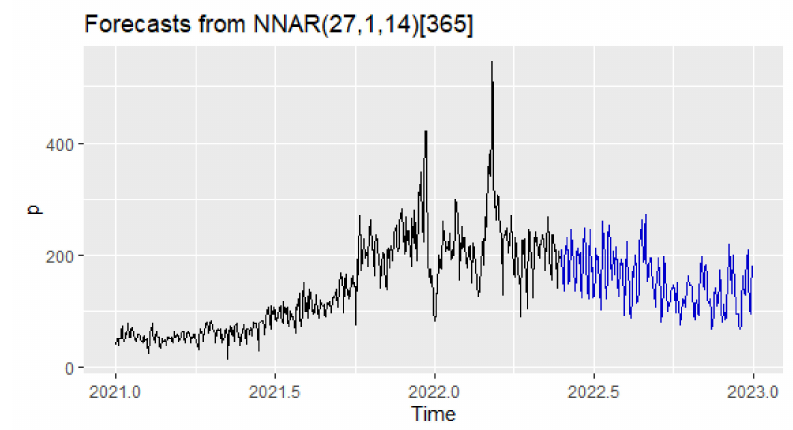
Figure 6. Price forecast using NNAR model. Table 6. Estimated NNAR model.